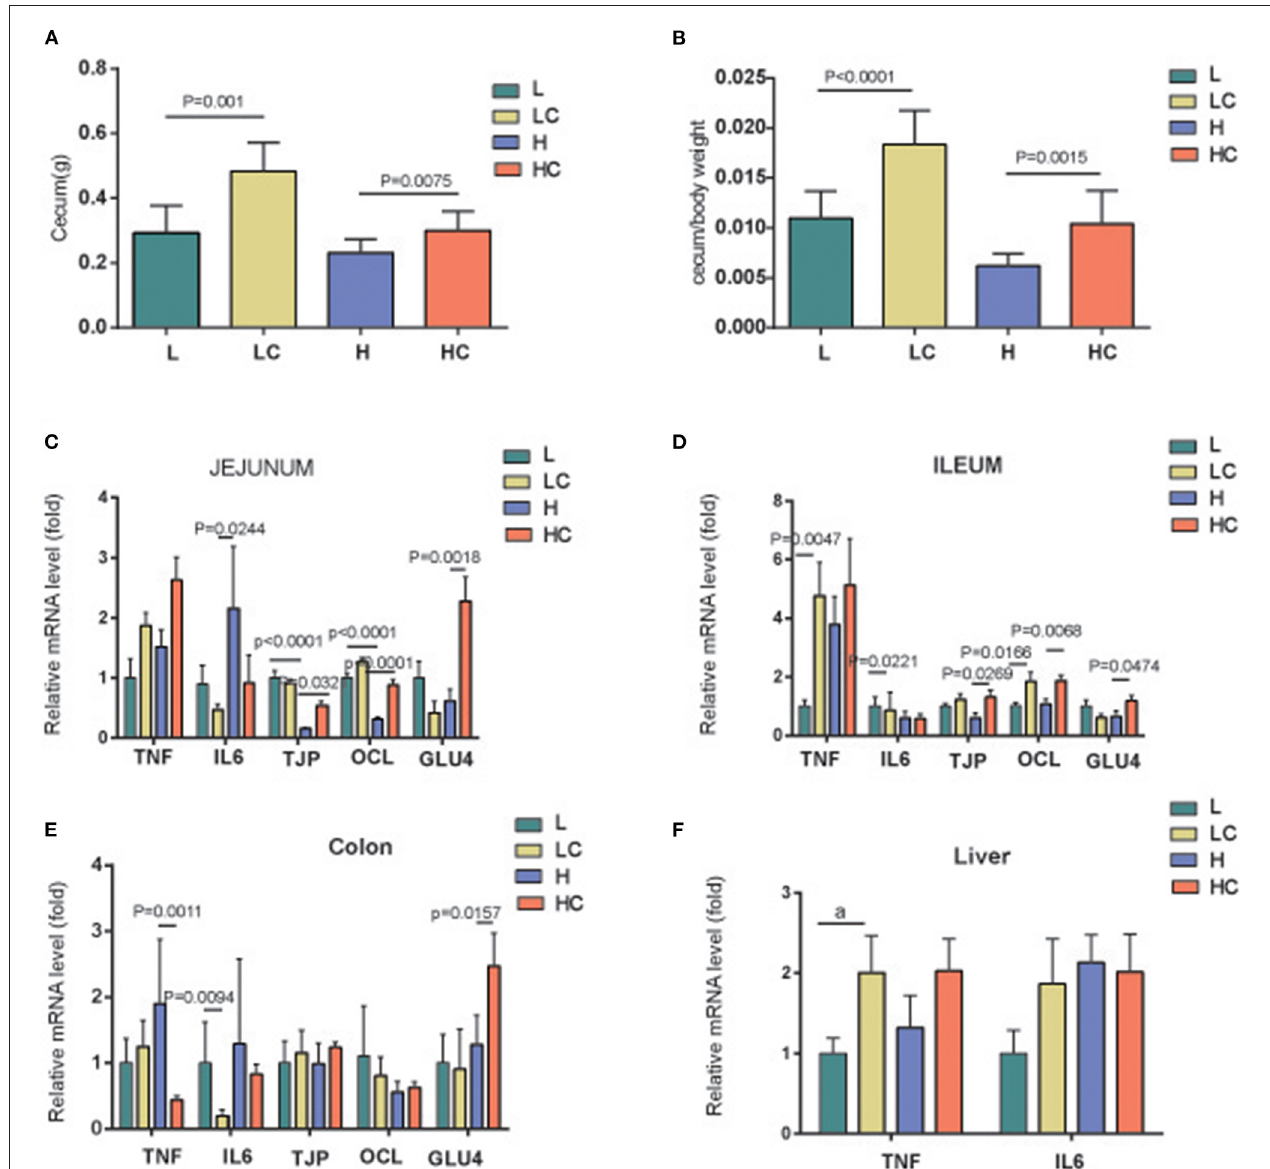
FIGURE 5 | Gene expression of the cells in gut and liver. Cecum weight (A) , cecum/body weight (B) of each group, and gene expressions in jejunum (C) , ileum (D) , colon (E) and liver (F) . Groups: Group L (low-fat diet group, fed with 4.3% fat, 5% cellulose); LC group (low-fat diet + COS group, fed with 4.3% fat, 5% COS); group H (high-fat diet group, fed with 35.4% fat, 5% cellulose); and HC group (high Fat diet + COS group, fed with 35.4% fat, 5% COS).